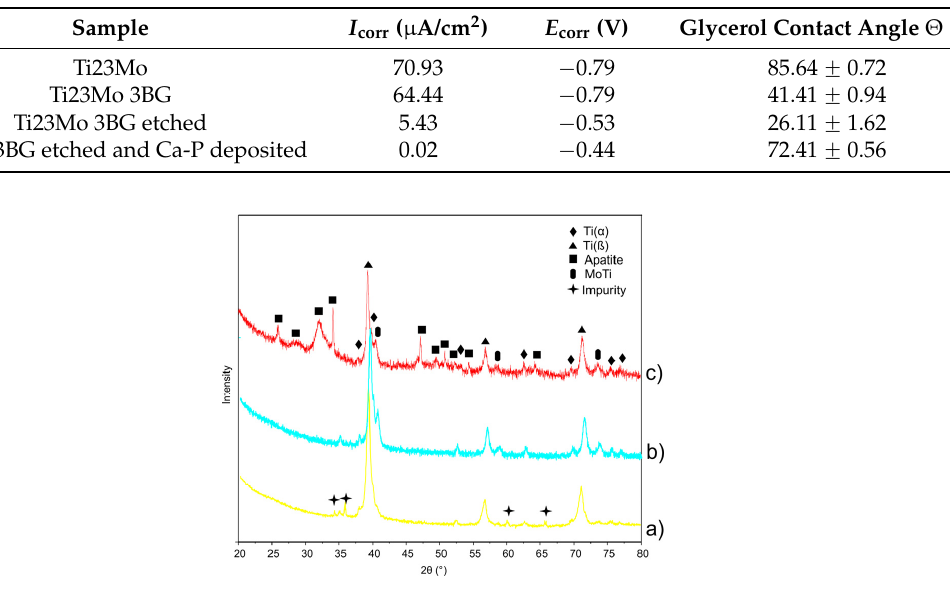
Figure 5. X-ray diffraction (XRD) spectra of Ti23Mo 3BG nanocomposite before ( a ) and after the surface biofunctionalization ( b , c ); etched ( b ) and Ca-P deposited ( c ).